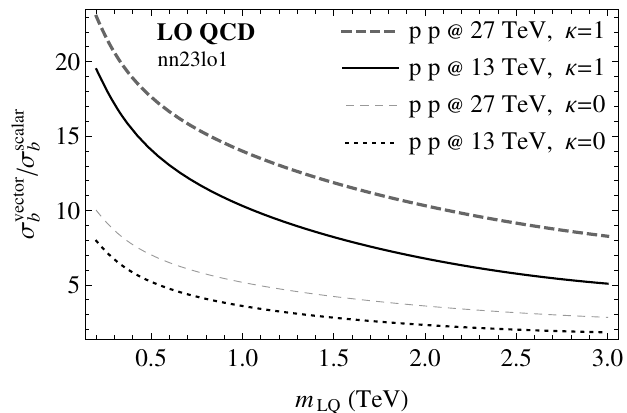
Figure 4 . Ratio of total inclusive cross sections at the LO in QCD for the single production of a vector LQ ( (cid:27) vector ) and a scalar LQ ( (cid:27) scalar ) through a fusion of b and (cid:22) b quarks with gluons b b